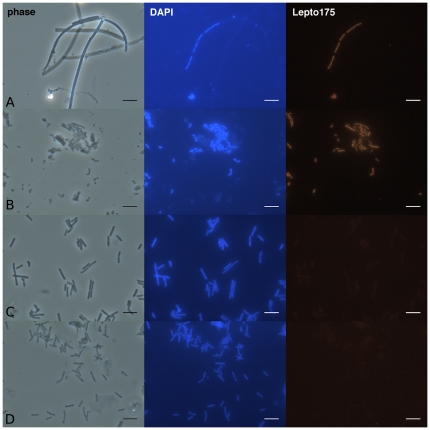
Micrographs of LD iron-mats (row A), O. thiooyxgens, (row B), S. natans (row C) and L. cholodnii SP-6 (row D) viewed with phase contrast, epi-florescence stained with DAPI, and epi-florescence with the Lepto175 probe applied.Scale bar is 5 µm. Cells were hybridized with the Lepto175 probe (hybridized at a 15% formamide concentration).